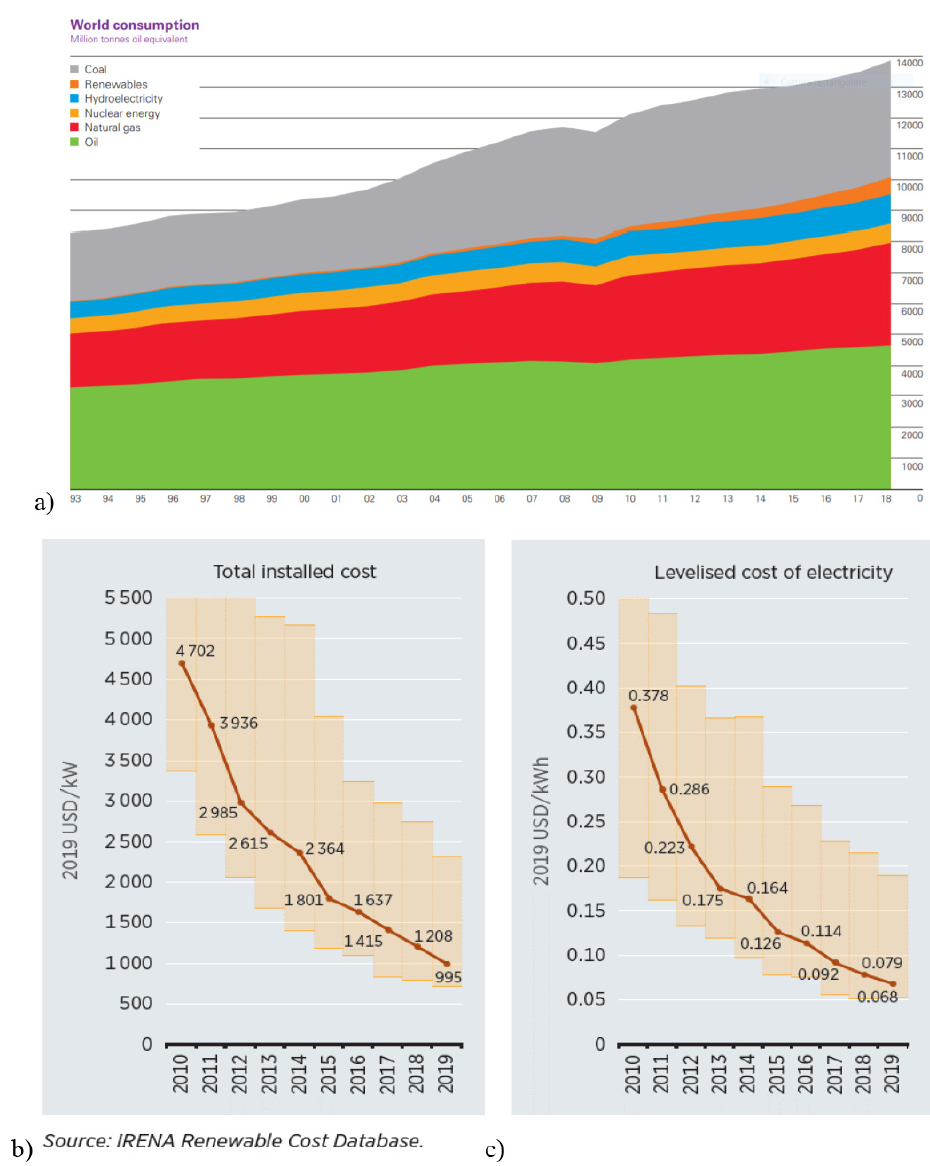
Fig. 1. – Statistical review: (a) the graph shows the global trend of energy sources consumption starting 1993 up to 2018. Taking into account coal (in grey), renewable sources (solar, wind and geothermal in orange), hydroelectric (in blue), nuclear (in light orange), natural gas (in red) and oil (in green) [2]. Global weighted average (b) total installed costs and (c) LCOE for PV, 2010–2019. The bars represent the interval between the 95th and 5th percentile. (Adapted from https://www.irena.org/publications/2020/Jun/Renewable-Power-Costs-in-2019